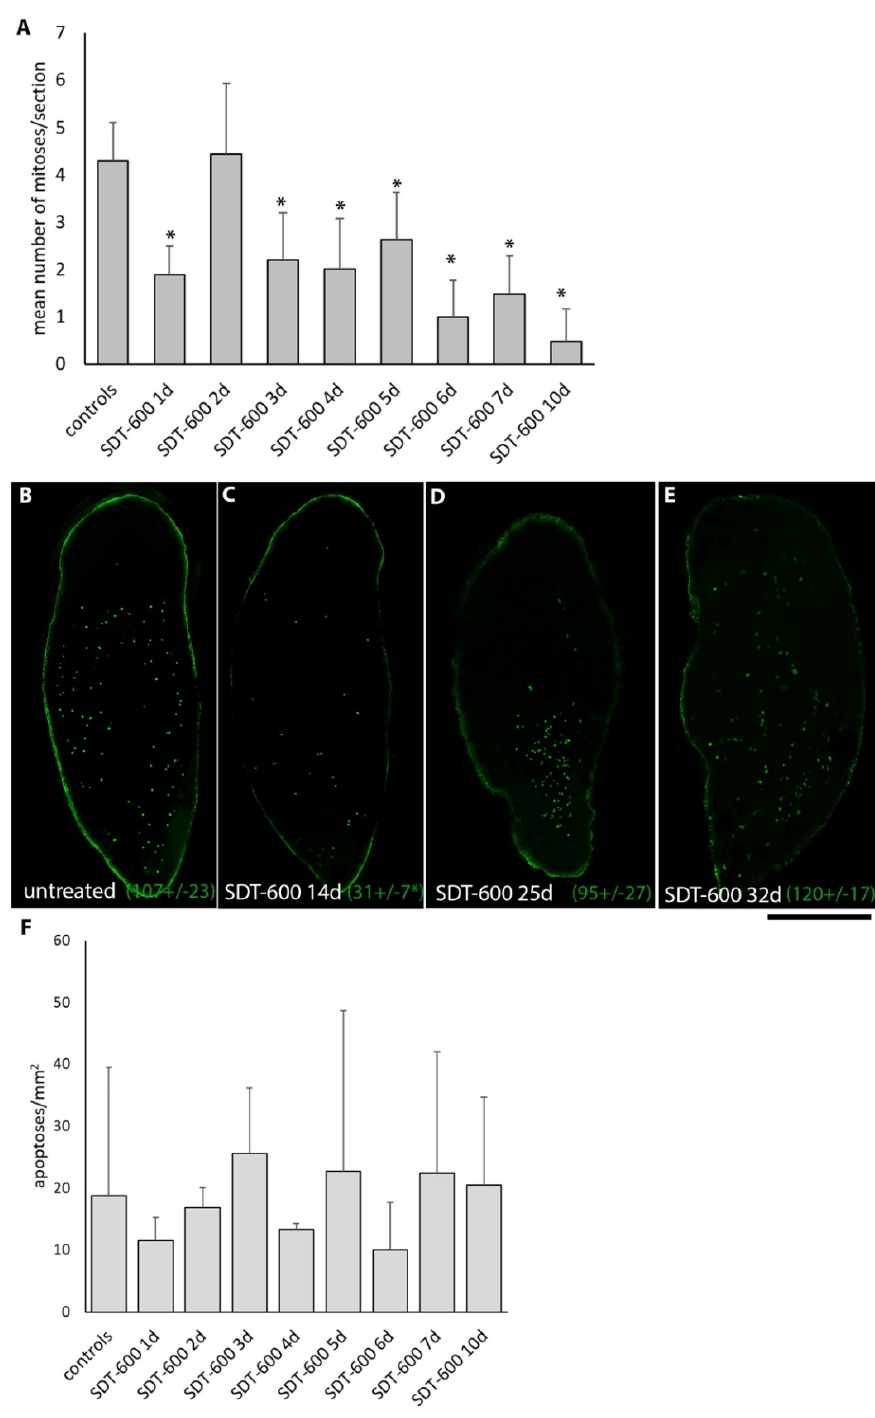
Figure 5. Analysis of mitotic and apoptotic cells. ( A ) Histogram depicting the mean number of H3p-positive cells counted during the first 10 days of treatment. Each bar is the mean value ± SD from five independent animals. Asterisks indicate a statistically significant difference (* p < 0.01) evaluated by the non-parametric, two-tailed Mann–Whitney U -test versus untreated controls. ( B – E ) Representative images of whole-mount H3p immunostaining. Mean number of H3p-positive cells ± SD are indicated in brackets; asterisk indicates a statistically significant difference (* p < 0.05) evaluated by the non-parametric, two-tailed Mann–Whitney U -test versus untreated controls. ( F ) Histogram depicting the mean number of TUNEL-positive cells counted during the first 10 days of treatment. Each bar is the mean value ± SD from five independent animals. No significant differences were evaluated by the non-parametric, two-tailed Mann–Whitney U -test versus untreated controls. Scale bar corresponds to 500 µ